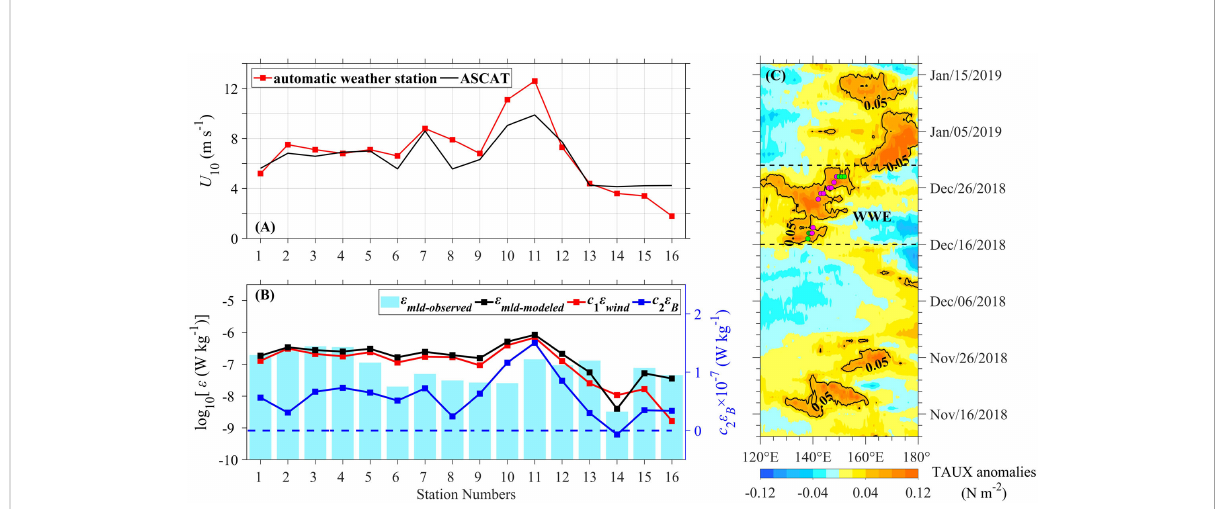
FIGURE 3 Station series of (A) wind speed at 10-m height above the sea surface ( U 10 ) from shipboard Vaisala automatic weather station (red) and ASCAT (black), and (B) mean TKE dissipation rates over the mixed layer from observation ( e mld-observed , bar charts), model ( e mld-modeled , black), and its two components induced by wind ( e wind , red) and convection ( e B , blue). (C) Longitude-time variation of ASCAT zonal wind stress (TAUX) anomalies averaged over 5°S – 5°N with measurement stations indicated. The westerly wind event (WWE) is denoted by two horizontal dashed black